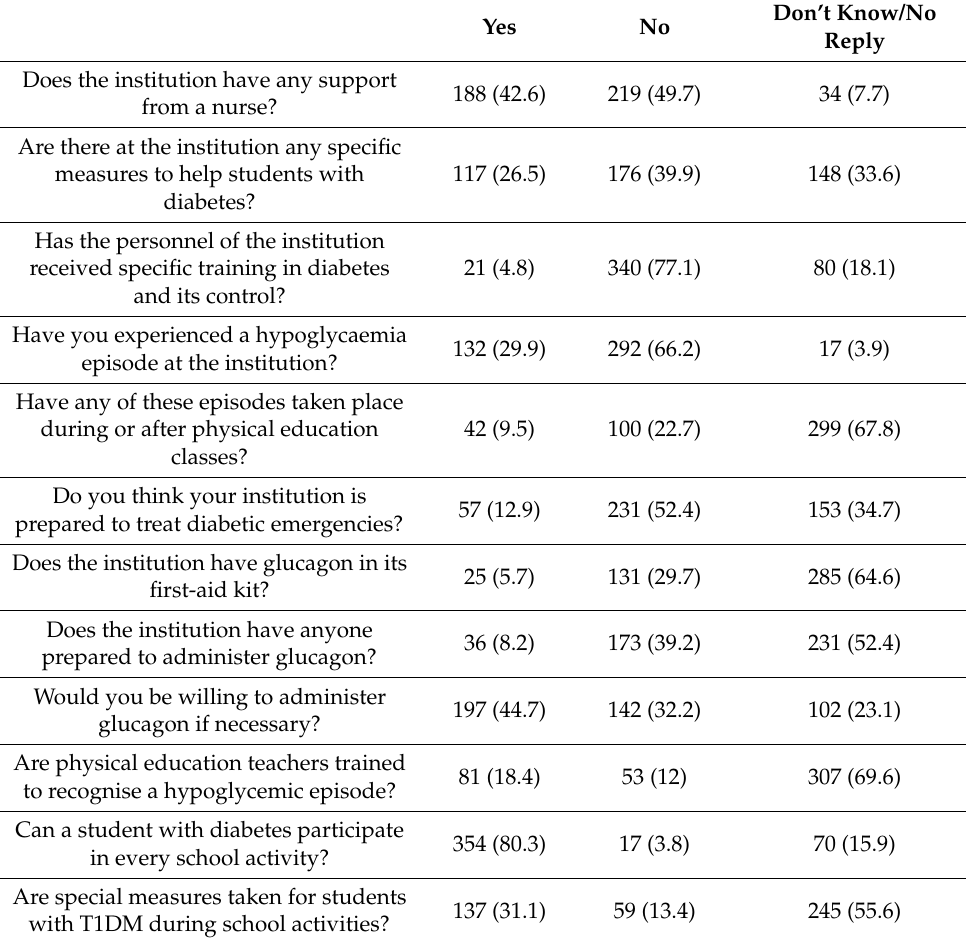
Table 2. Answers to the questionnaire Attitudes and perception of teachers regarding the capacity of the educational institution to provide needed care to students with diabetes ( n = 441, frequencies and